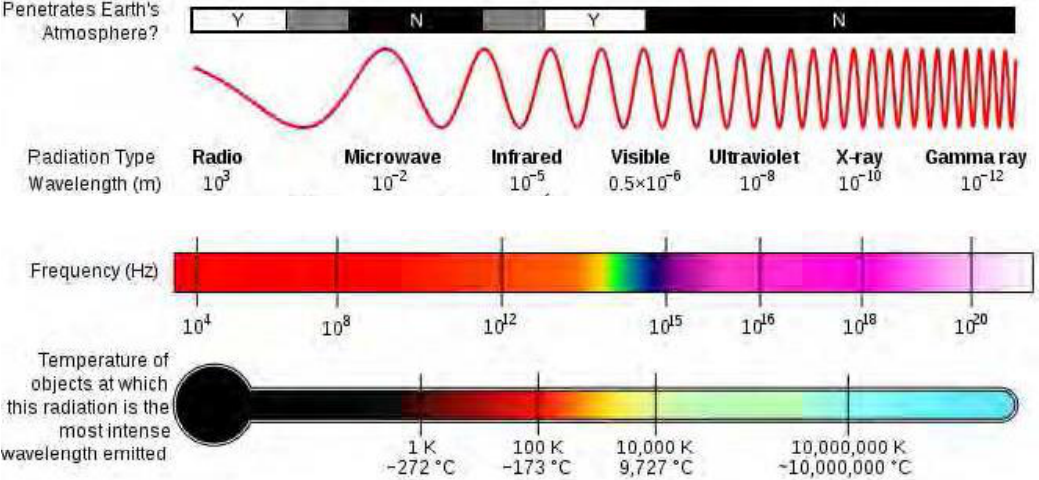
Fig.1: Spectral ranges of electromagnetic